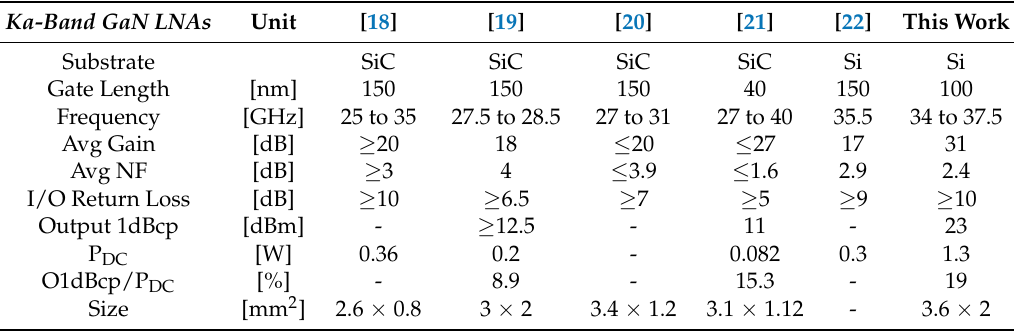
Table 5. Performance comparison with published